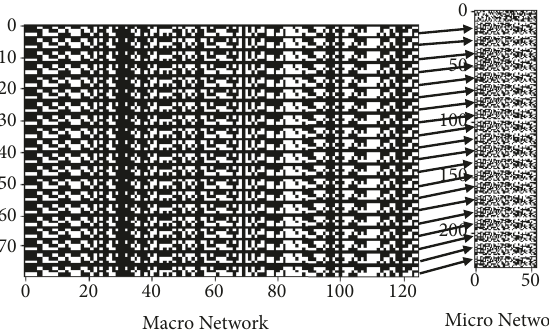
Figure 16: Temporal dynamics (time moves downward, columns represent nodes, and colors represent states) showing how an attractor of the macronetwork generates an attractor in an chaotic